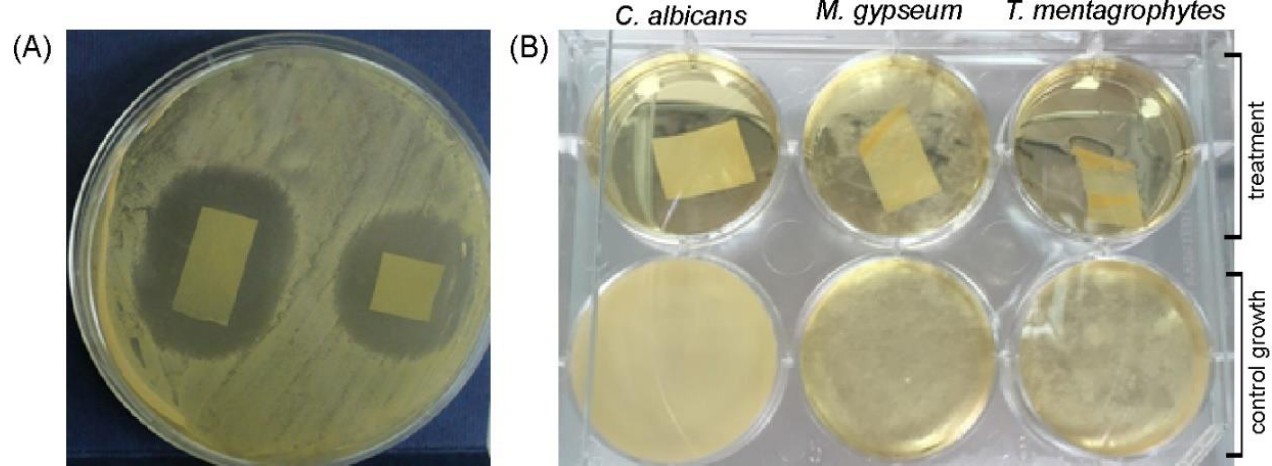
Figure 4. In vitro antifungal activity of AMB-M film ( A ) in direct contact on agar plates against C. albicans after 24 h incubation at 37 °C and ( B ) in broth assay with C. albicans , M. gypseum and T. mentagrophytes (control fungal growth in SAB medium is shown in bottom wells).